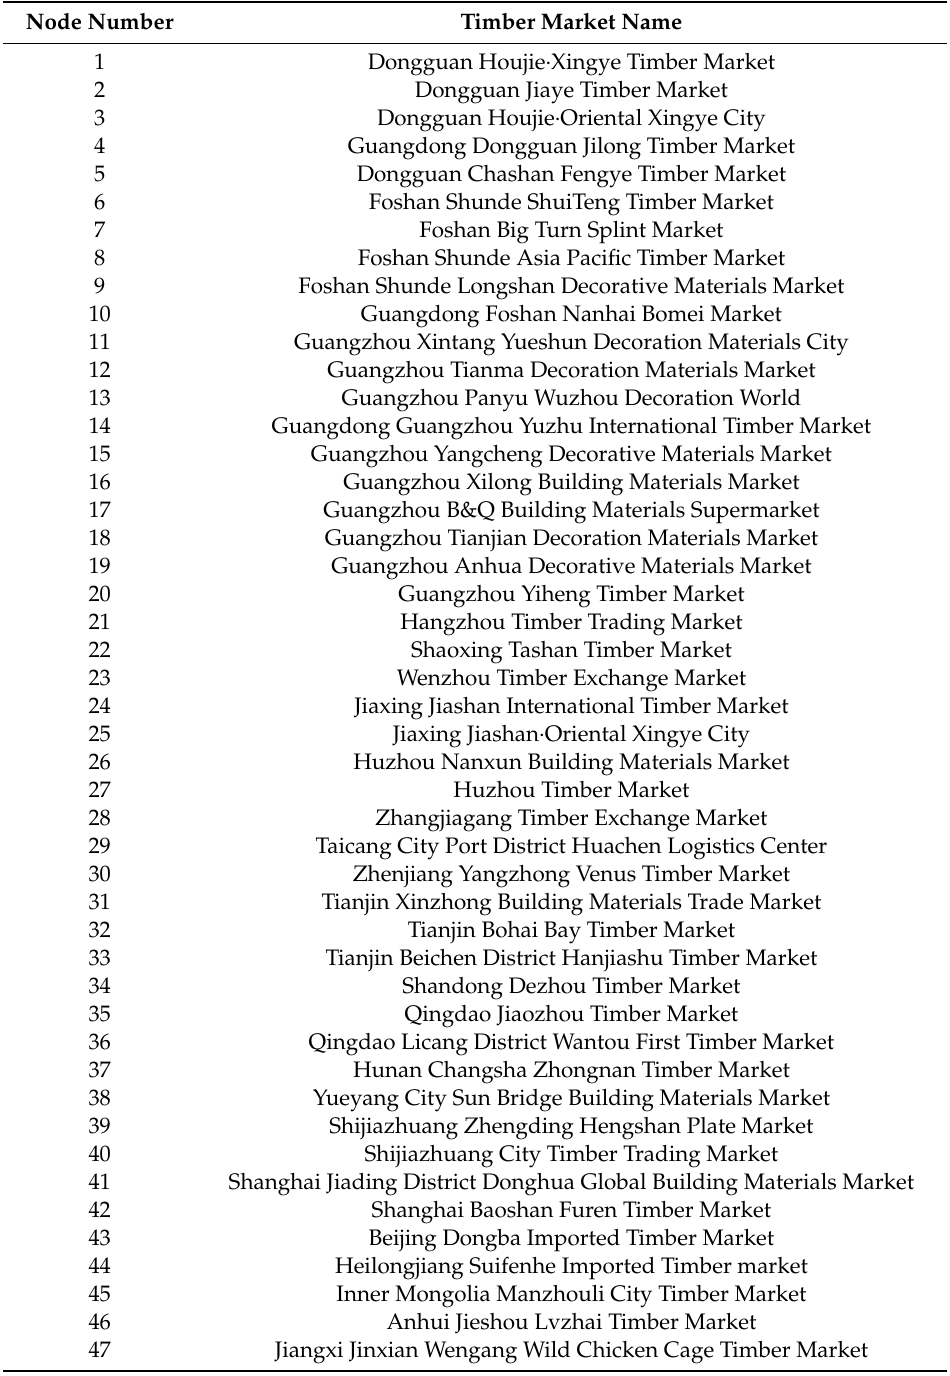
Table 1. Details of 47 timber